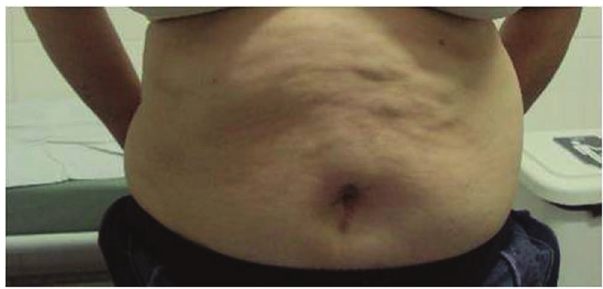
Figure 4 - Aesthetic aspect, six